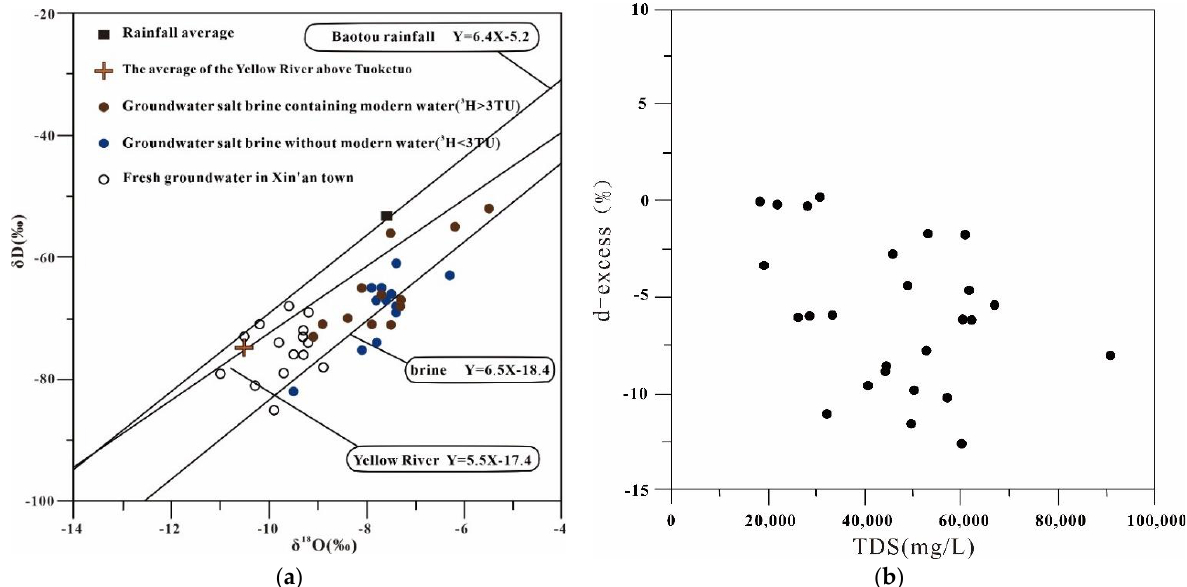
Figure 13. ( a ) Hydrogen and oxygen stable isotope composition of subsurface brine in Xishanzui; ( b ) Relationship between deuterium excess and TDS of highly mineralized groundwater samples in Xishanzui. Deuterium excess (Dxs) is defined as: d = δD - 8δ 18 O, Dxs representing the offset from